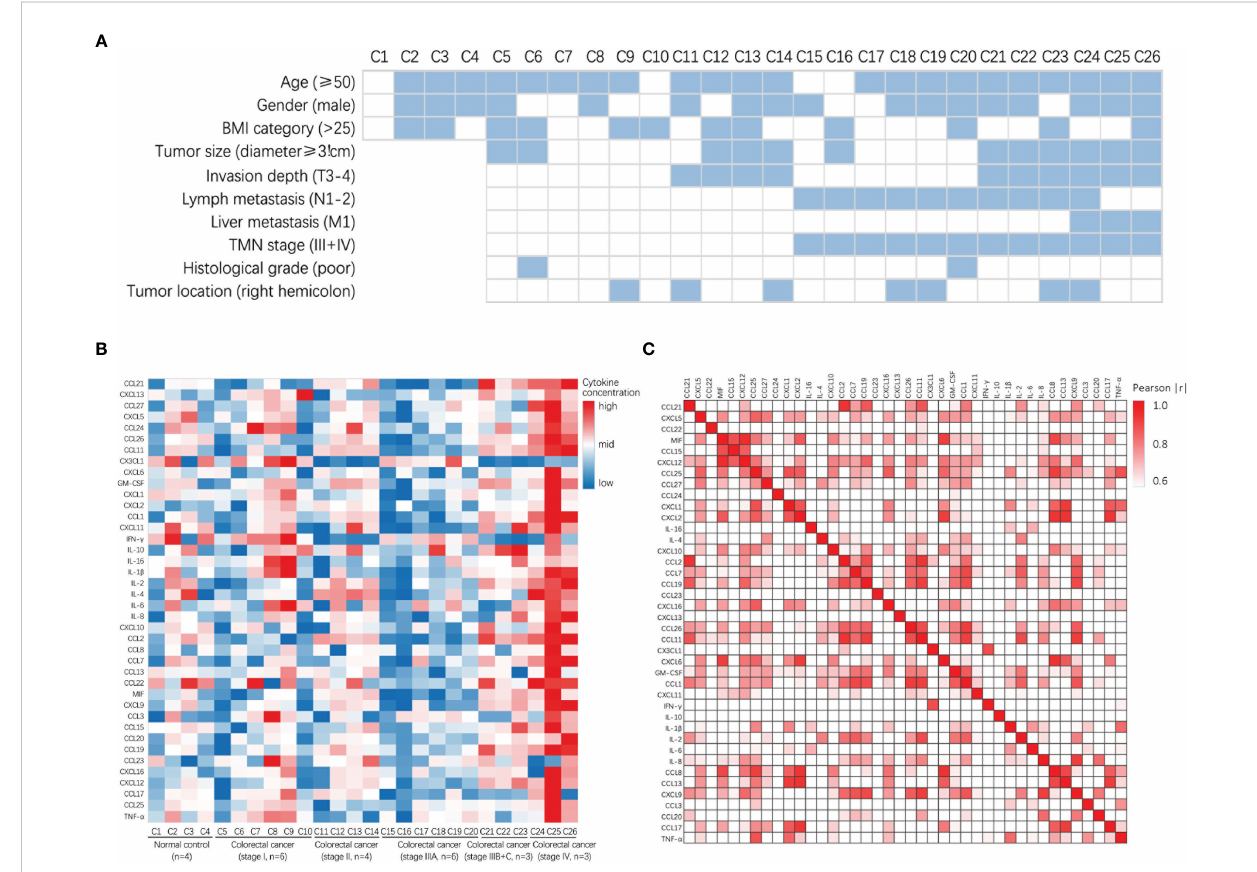
FIGURE 1 Clinical characteristics and the concentrations of cytokines in patients with colorectal cancer and normal control. (A) Heatmap shows clinical characteristics of 26 patients for Luminex assay. (B) Heatmap of differentially expressed 40 serum multi-cytokines between participants with colorectal cancer patients and non-tumor patients (healthy controls) using Luminex assay. (C) Correlation heatmap of 40 serum cytokines in CRC patients and non-tumor patients (healthy